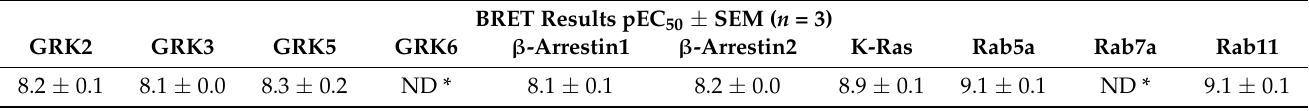
Figure 1. β -arrestin1 and β -arrestin2 recruitment to ACKR3 upon CXCL12 stimulation. ( a ) CXCL12-induced β -arrestin1 and β -arrestin2 recruitment to ACKR3 over time as measured by BRET in ACKR3 WT HEK293T cells; ( b ) Agonist-induced β -arrestin1 and β -arrestin2 recruitment to ACKR3 by increasing concentrations of CXCL12 as measured by BRET in HEK293T cells. Representative curves of three independent experiments with triplicates shown as mean ± SD. Table 1. pEC 50 of CXCL12 activating ACKR3 in various BRET